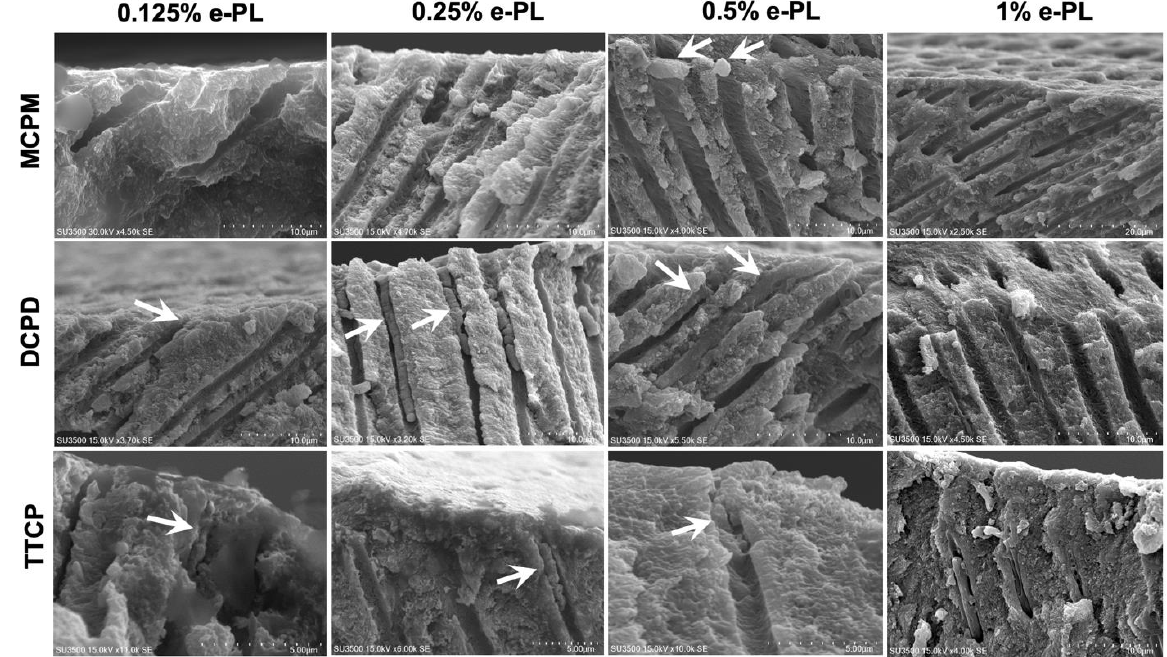
Figure 7. SEM images of longitudinal fractured dentin discs after 72 h of incubation in artificial saliva following CPP and ε -PL application. Arrows depict the crystallizations formed inside the dentin tubules.